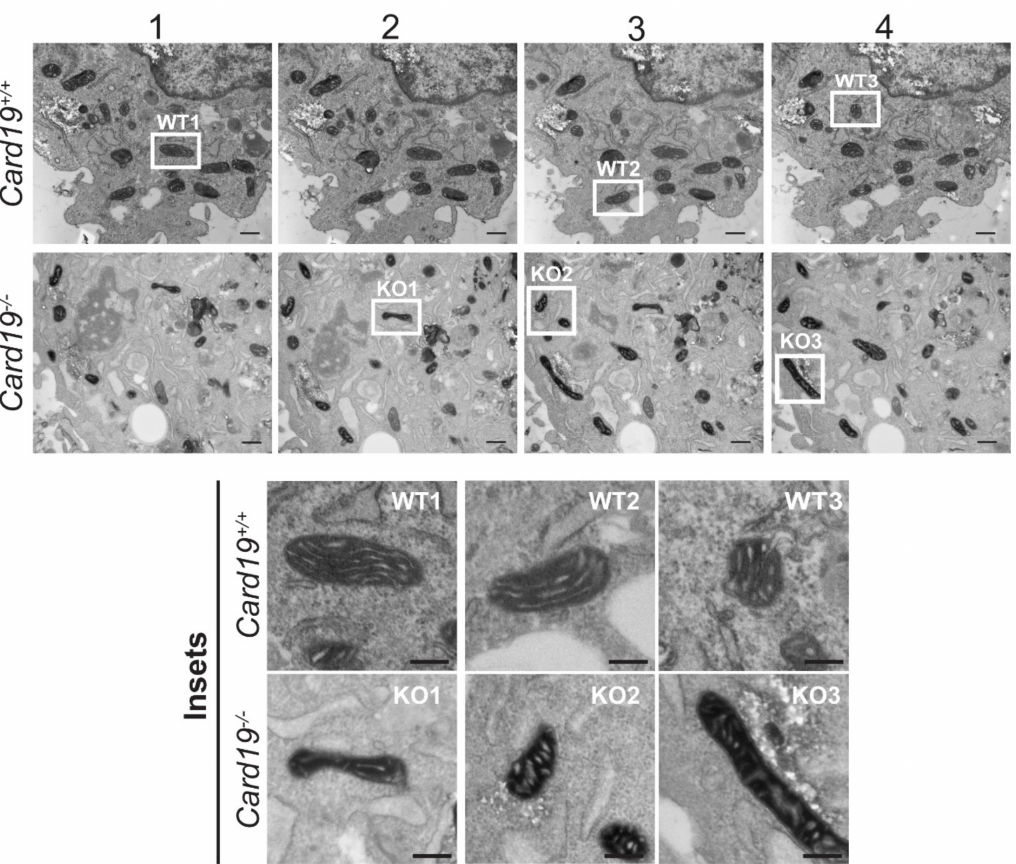
Figure 5. Card19 − / − fibroblasts cultured in glucose-free, galactose-supplemented medium exhibit altered cristae morphology. Immortalized lung fibroblasts from Card19 +/+ and Card19 − / − mice were cultured for 5 days in glucose-free, galactose-supplemented DMEM, followed by serial sectioning and TEM analysis. The images shown are successive sections approximately 80–90 nm apart. Insets correspond to the respective, labeled white boxes in the full-sized images. Bar, 500 nm for full-sized images and 250 nm for